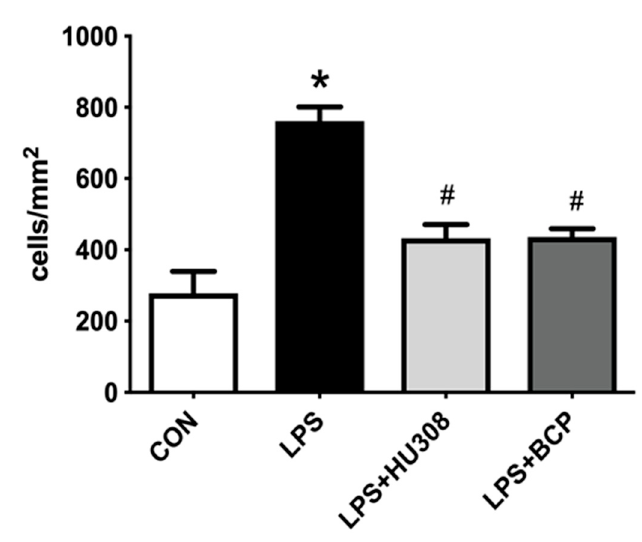
Figure 3. Leukocyte adhesion in submucosal bladder venules of female CD-1 mice for the following experimental groups: control (CON; n = 9), lipopolysaccharide (LPS)-induced interstitial cystitis (IC) (LPS; n = 9), LPS-induced IC treated with HU308 (5 mg/kg, LPS + HU308; n = 4), LPS-induced IC treated with beta-caryophyllene (BCP) (100 mg/kg, LPS + BCP; n = 7). LPS, BCP, and HU308 were all administered via i.p. injection. Data presented as mean ± SD. * p < 0.05 vs. CON. # p < 0.05 vs. LPS.